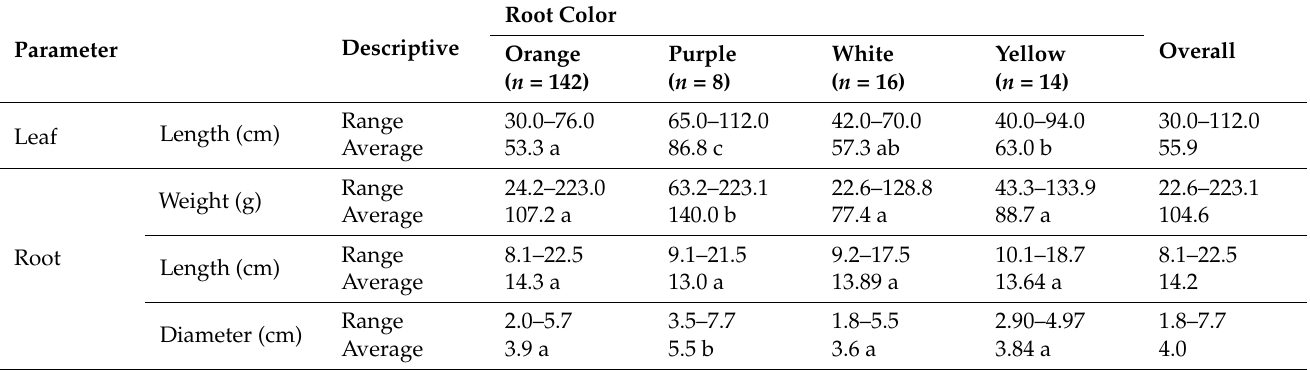
Table 2. Variation in quantitative traits in carrot genetic resources ( n =